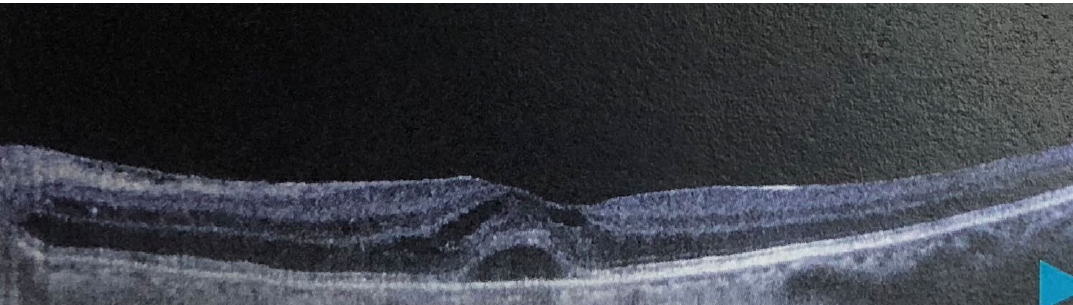
Figure 3: Left OCT: separation in the inner retinal layers with a variable degree of macular oedema